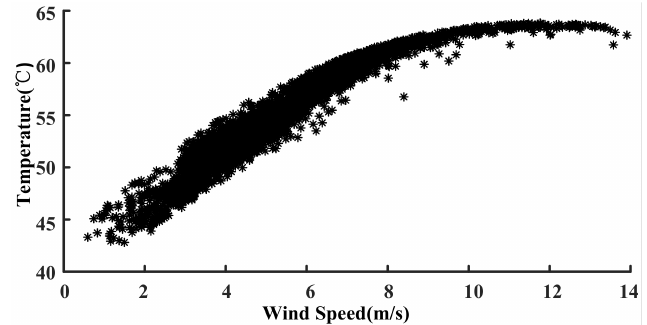
Figure 7. Scatterplot between gearbox bearing temperature and wind